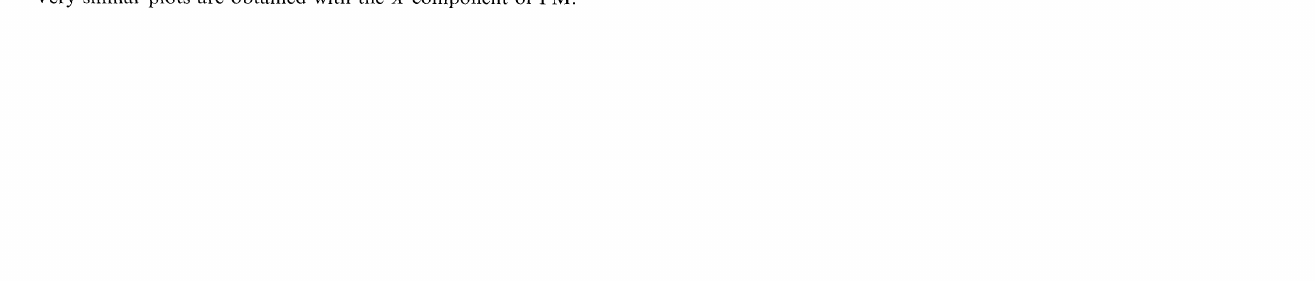
FIGURE The raw time series of the Y-PM (upper panel) is splitted into a secular trend (scaled by a factor 2), the Chandler (period 433 days) and annual (period 365.25 days) wobbles and an irregular or residual part (lower panel). Units are in mas. Very similar plots are obtained with the X component of